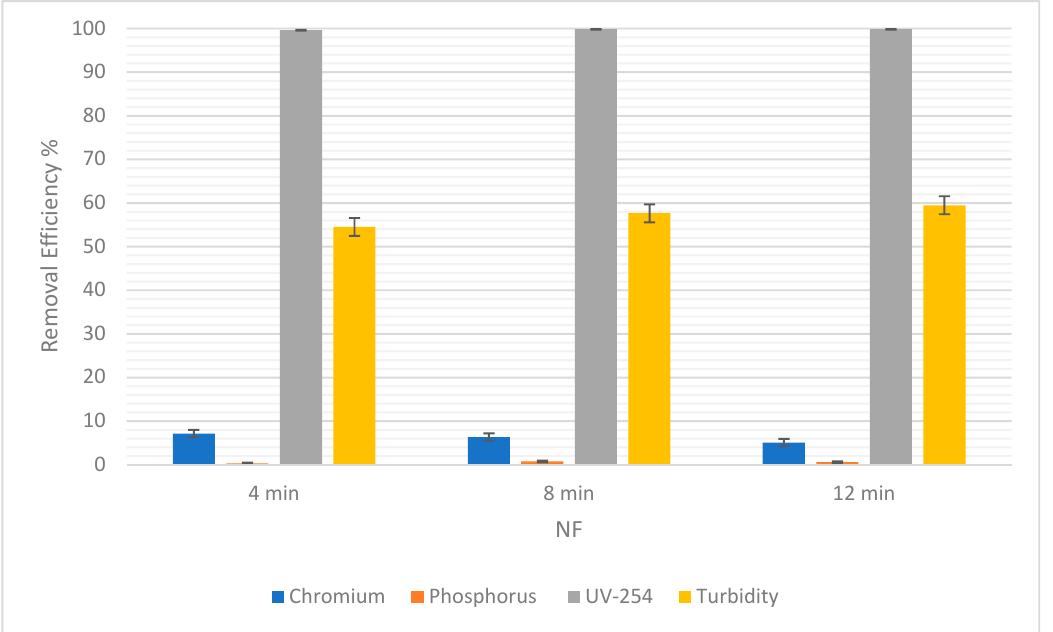
Figure 10. The removal efficiency of pollutants for NF at 4, 8, and 12 min. Table 6. Average ± SD at different timings.